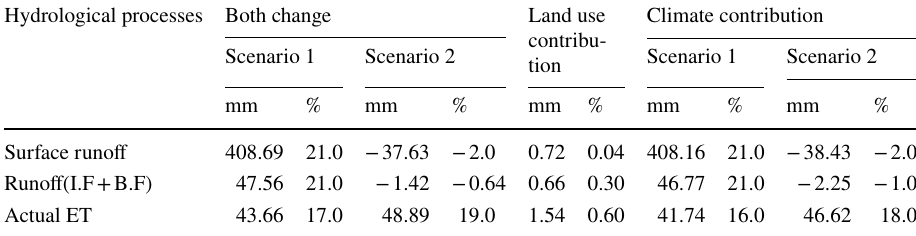
Table 7 Impacts of land-use/ future climate changes on hydrological processes